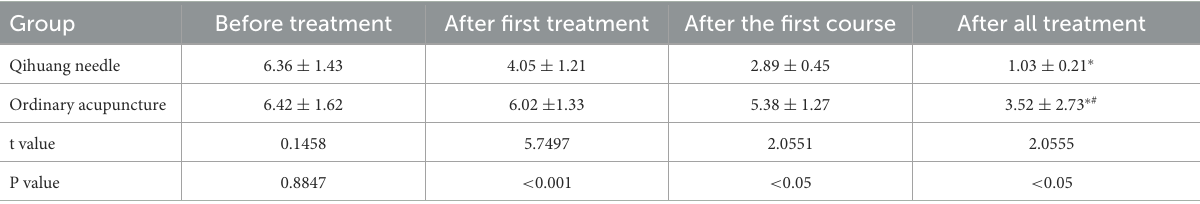
TABLE 3 Tanaka Yasuhisa Scale scores before and after treatment (mean ± SD). Group Before treatment After first treatment After the first course After all treatment